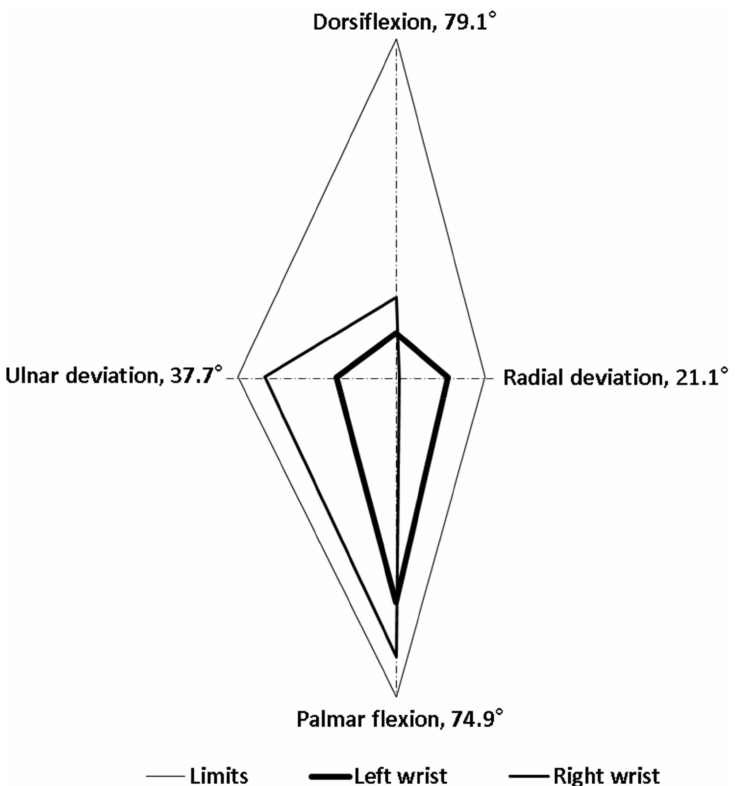
Figure 3. Maximum range of motion of the wrist joint during dough kneading.